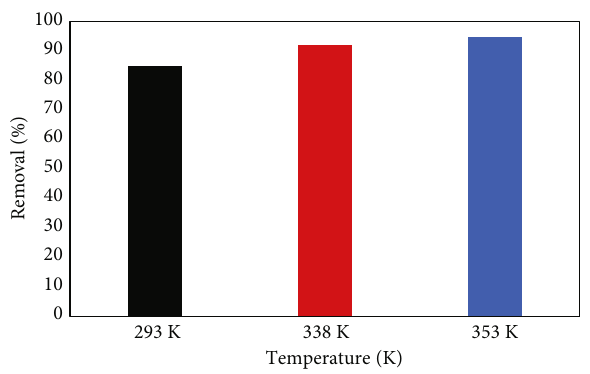
Figure 9: MB removal at di ff erent temperatures (293K, 338K, and 353K) with static adsorption condition: pH = 8 , dosage = 20mg/L , concentration = 10ppm , and contacttime = 30minutes